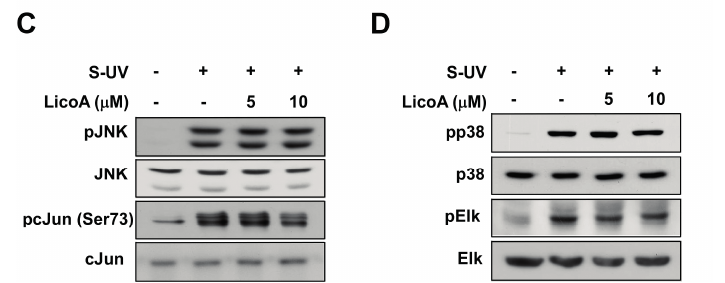
Figure 2. Effects of LicoA on sUV-dependent phosphorylation of the Akt/ mammalian target of rapamycin (mTOR), mitogen-activated protein kinase kinase (MEK)1/ extracellular signal-regulated kinases (ERKs)/p90 ribosomal protein S6 kinase (RSK), c-Jun N -terminal kinases (JNK)/c-Jun, and p38/Elk pathways in HaCaT cells. Cells were treated with 1.25, 2.5, 5, or 10 μ M LicoA for 1 h before sUV radiation, and harvested 30 min later. Phosphorylation levels as well as total mitogen-activated protein kinases (MAPKs) and Akt